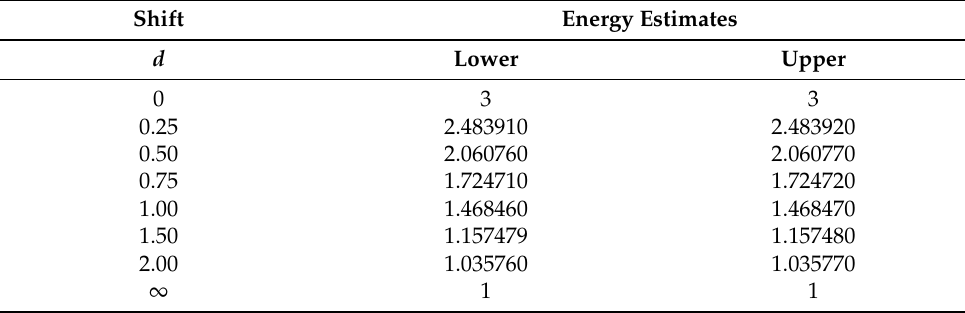
Table 4. The shift-dependence of the 1st-excited-state energy.